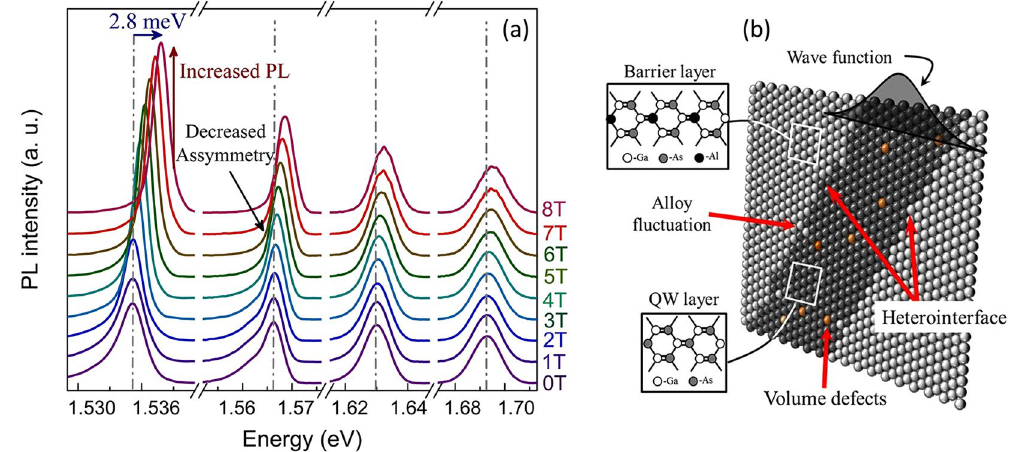
Figure 1. ( a ) PL Spectrum of AlGaAs/GaAs MQW sample at 4.2 K. Broadening in linewidth is more pronounced in thin QWs. Magnetic field dependent blue shift in PL line-shape is also observed. Asymmetry in PL line-shape is predominantly observed in thick QWs ( ≥ 50 Å). In presence of magnetic field, PL intensity increases and asymmetry in line-shape reduces. ( b ) Schematic cross-sectional view of AlGaAs/GaAs QW displaying hetero-interface atomic irregularities, volume defects, compositional and thickness fluctuation and the penetration of wave function into the barrier